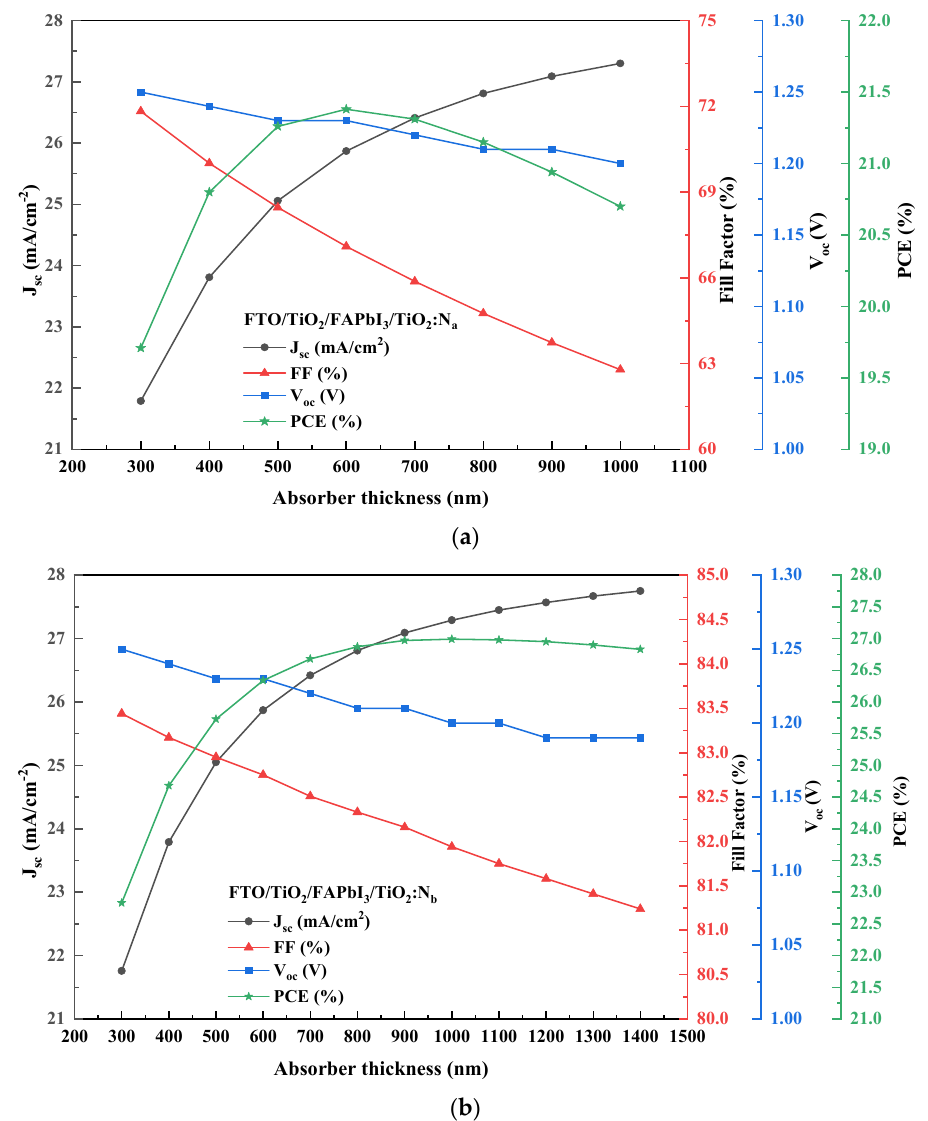
Figure 5. ( a ) Performance parameter curves for the FTO/FAPbI 3 /TiO 2 :N a recipe. ( b ) Performanc parameter curves for the FTO/FAPbI 3 /TiO 2 :N b recipe. parameter curves for the FTO/FAPbI 3 /TiO 2 :N b